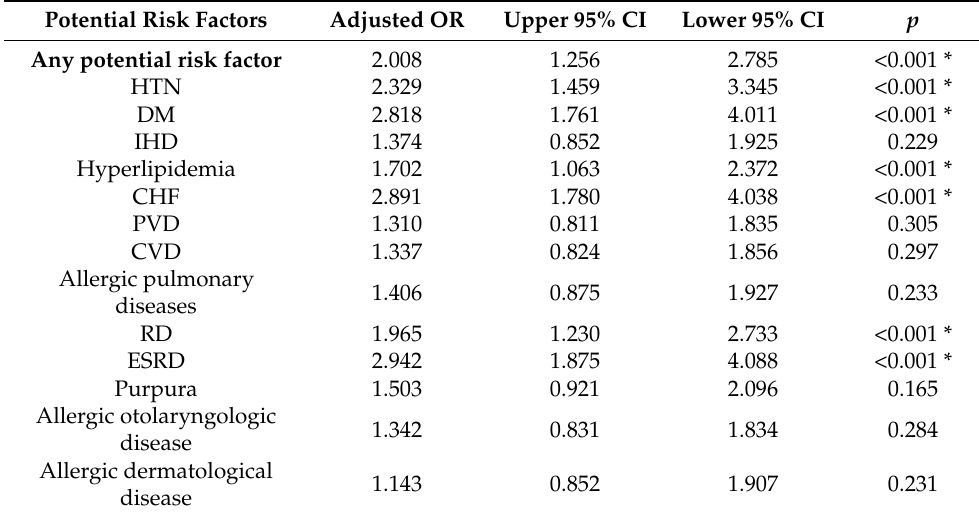
Table 4. Risk factors for cataract surgery with serious complications analyzed using multivariable conditional logistic regression among different exposures.